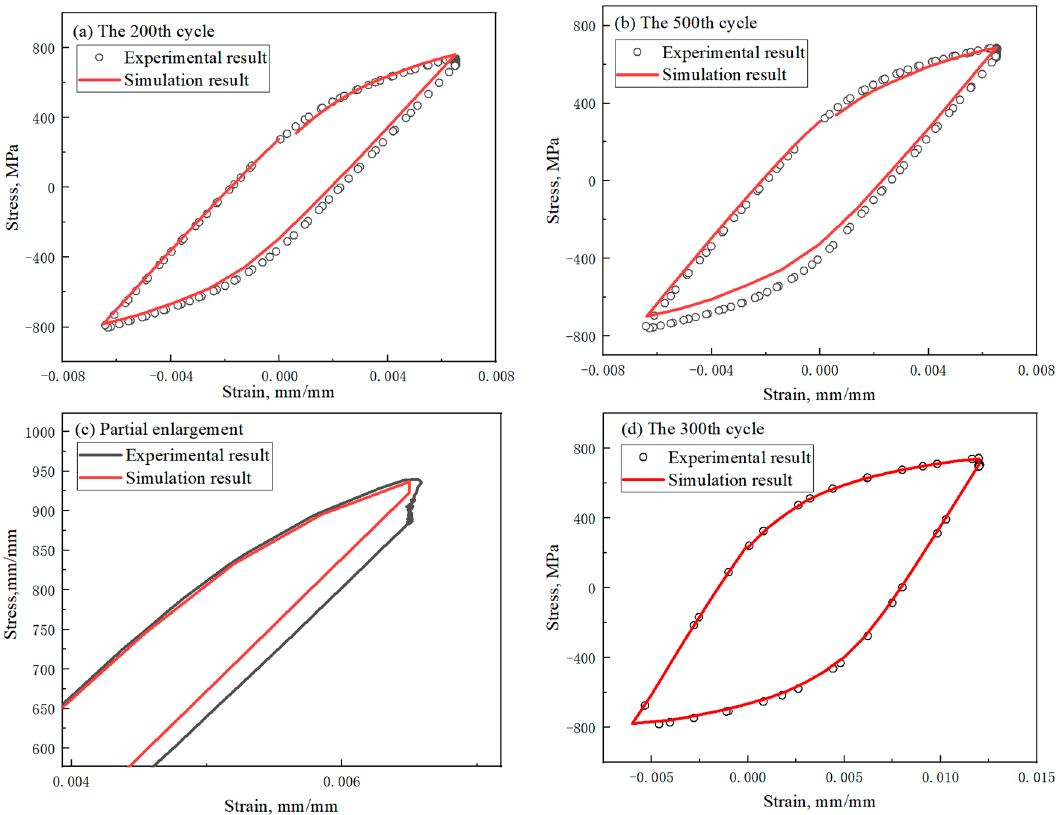
Figure 19. Comparison of creep-fatigue behavior between tests and simulations: ( a ) the 100th cycle; ( b ) the 500th cycle; ( c ) partial enlargement; ( d ) the 300th cycle.